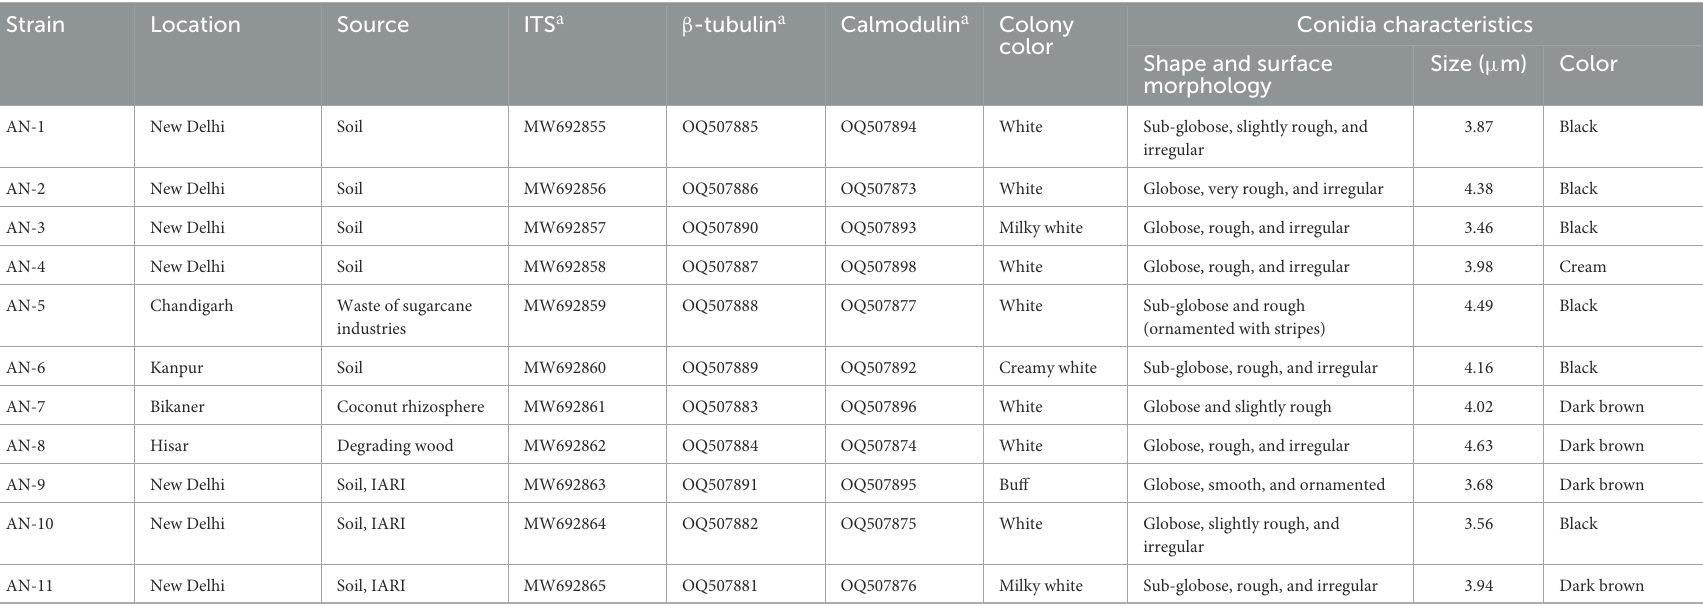
TABLE 1 Microscopic characteristics used for the identification of eleven strains of A. niger grown on potato dextrose agar (PDA) at 7 days after inoculation